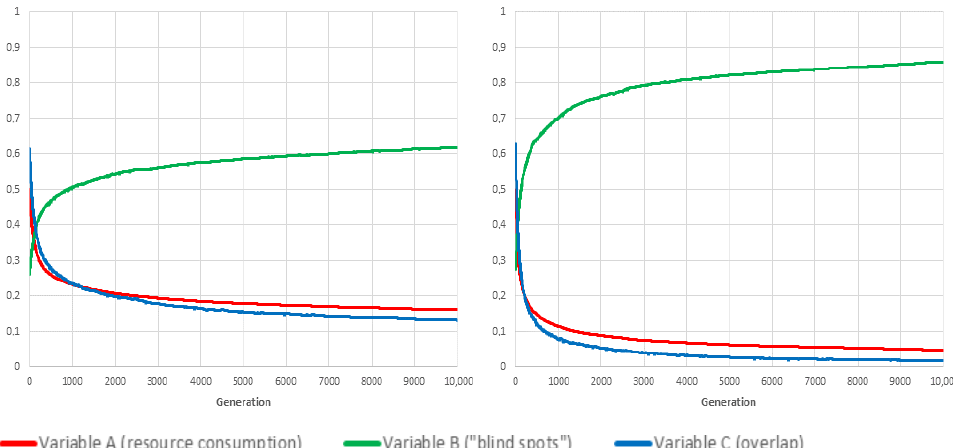
Figure 3. Benchmarking tests: α = 1 We show the evolution over time of variables A , B and C for the fittest individual of each generation (the plotted values are averaged over 20 independent realisations). If α = 1 then β , γ = 0; and F is equal to A . Consequently, the GA is optimising F by reducing the value of A to (eventually) zero. The convergence speed of the algorithm when using mutation only ( left panel) is significantly slower than with sexual reproduction ( right